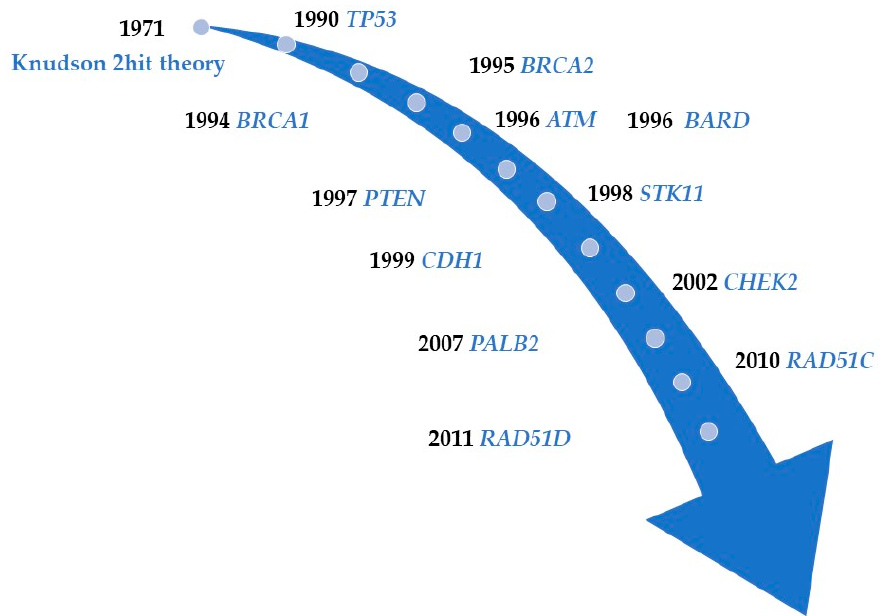
Figure 1. Timeline reflecting the identification of 12 breast cancer predisposition genes.